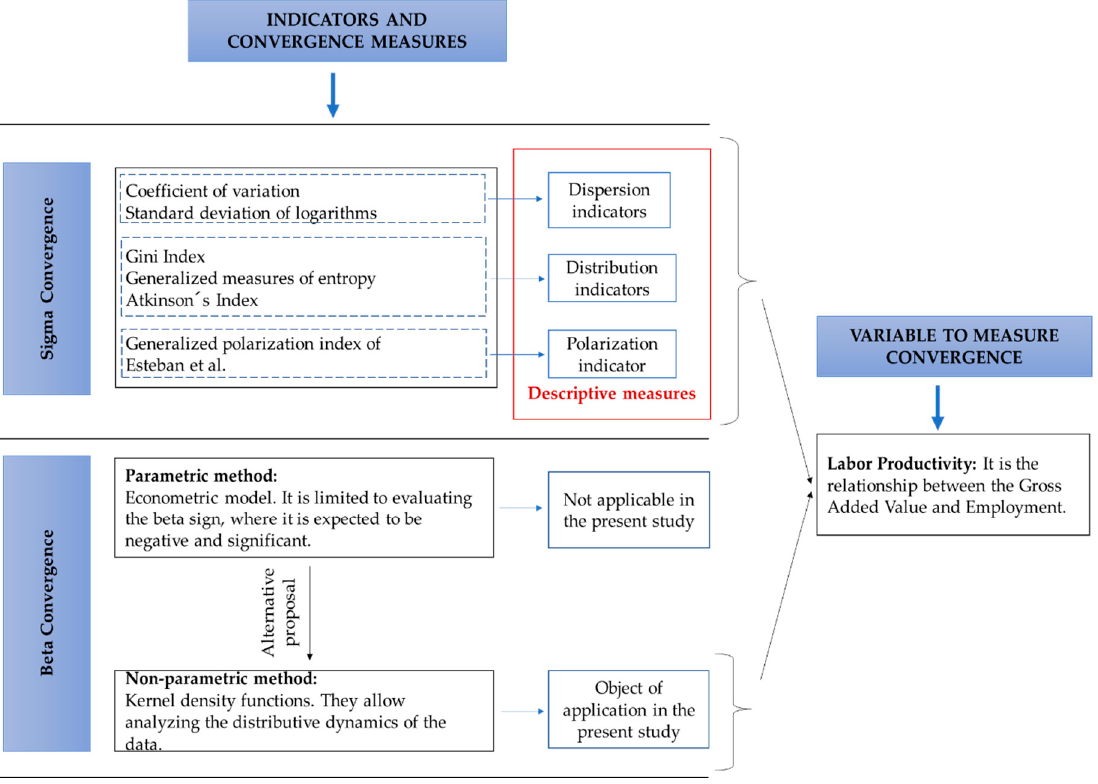
Figure 1. Indicators, and study variable.